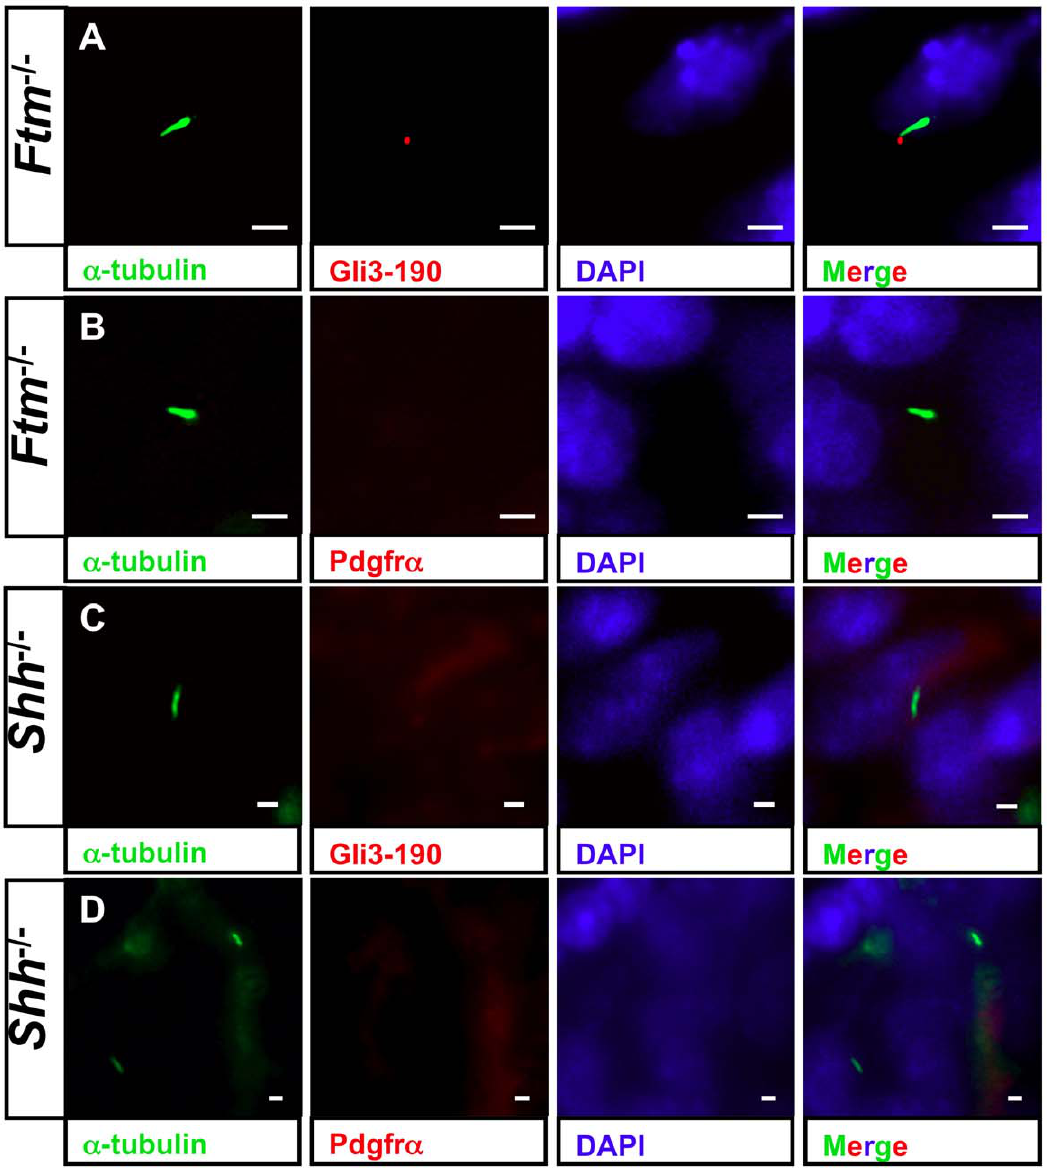
Figure 7. Shh signaling acts upstream of Pdgfr a signals in cardiac cilia. (A–D) Immunofluorescence on transverse heart sections at E11.5. Cilia are stained in green by acetylated a -tubulin and cell nuclei in blue by DAPI. Scale bars (in white) represent a length of 2 m m. (A) Gli3-190 (red staining) still shows a ciliary localisation in ventricular Ftm 2 / 2 cilia. (B) Pdgfr a (red staining) is absent in cilia of Ftm -deficient ventricles. (C) Gli3-190 protein is not observed at cilia of Shh 2 / 2 ventricles. (D) Pdgfr a cannot be detected in cilia of Shh -negative